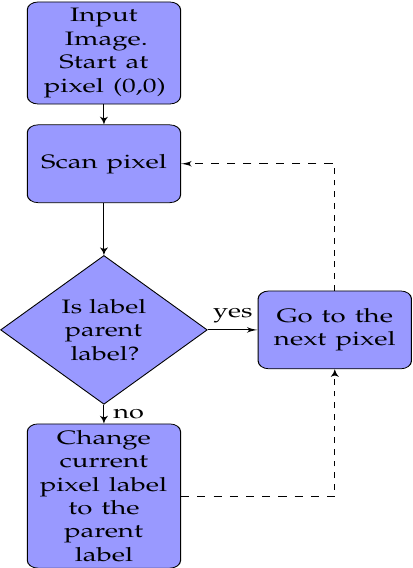
Figure 5. Connected Components algorithm second pass: